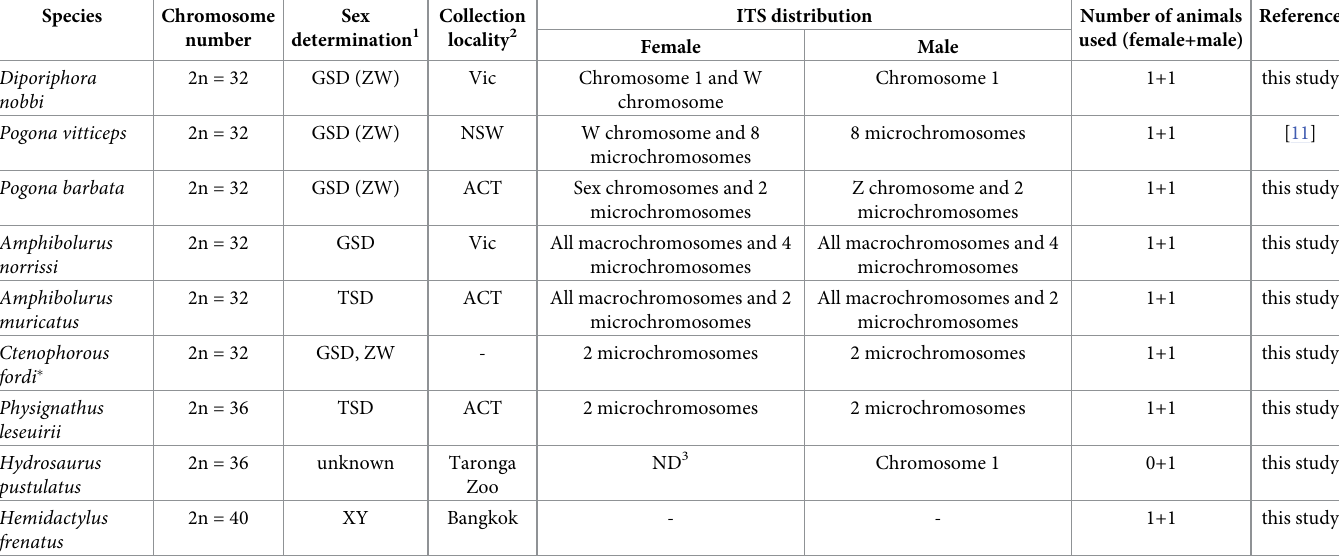
Table 1. List of species, collection sites and their interstitial telomeric sequence (ITS) distribution.